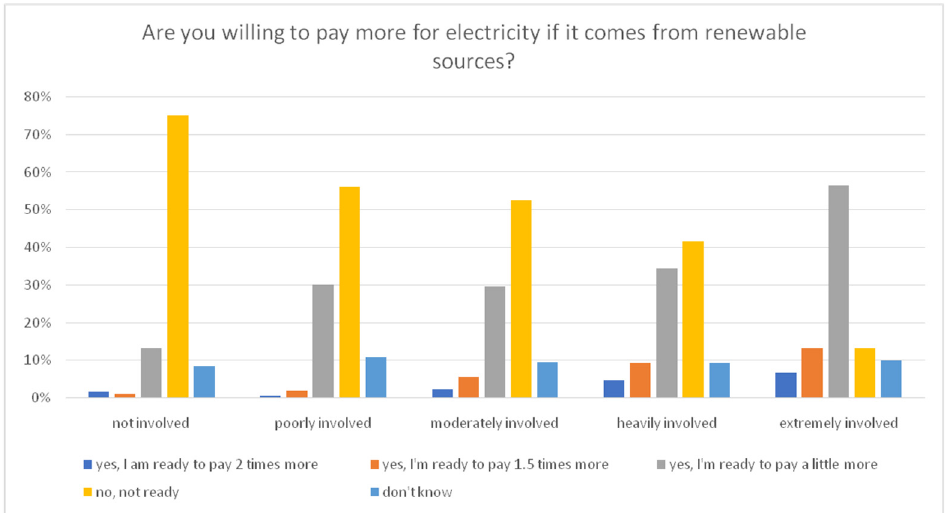
Figure 3. Attitude of respondents to environmental issues.